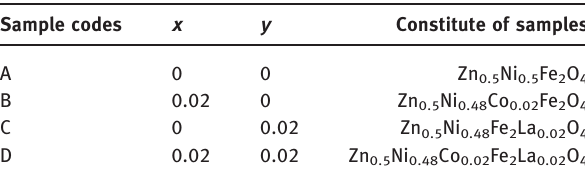
Table 1: Sample codes for NiZn ferrites synthesized via standard technique.